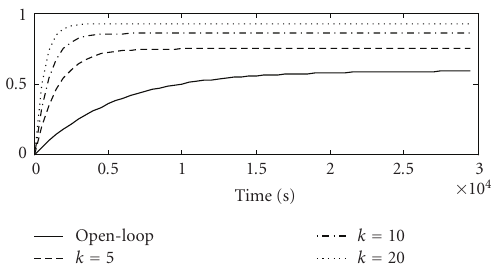
Figure 5: Step responses corresponding to Example